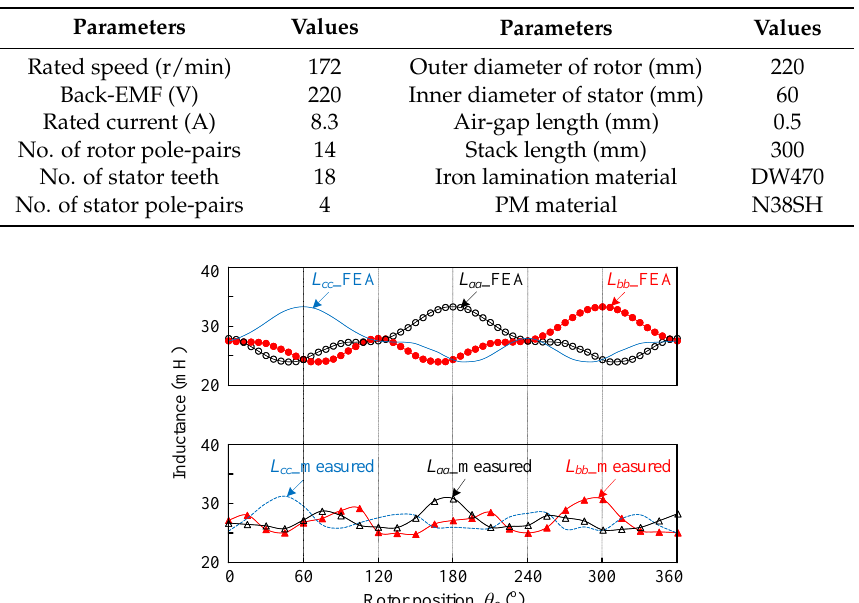
Table 5. Design specifications of the prototype machine.